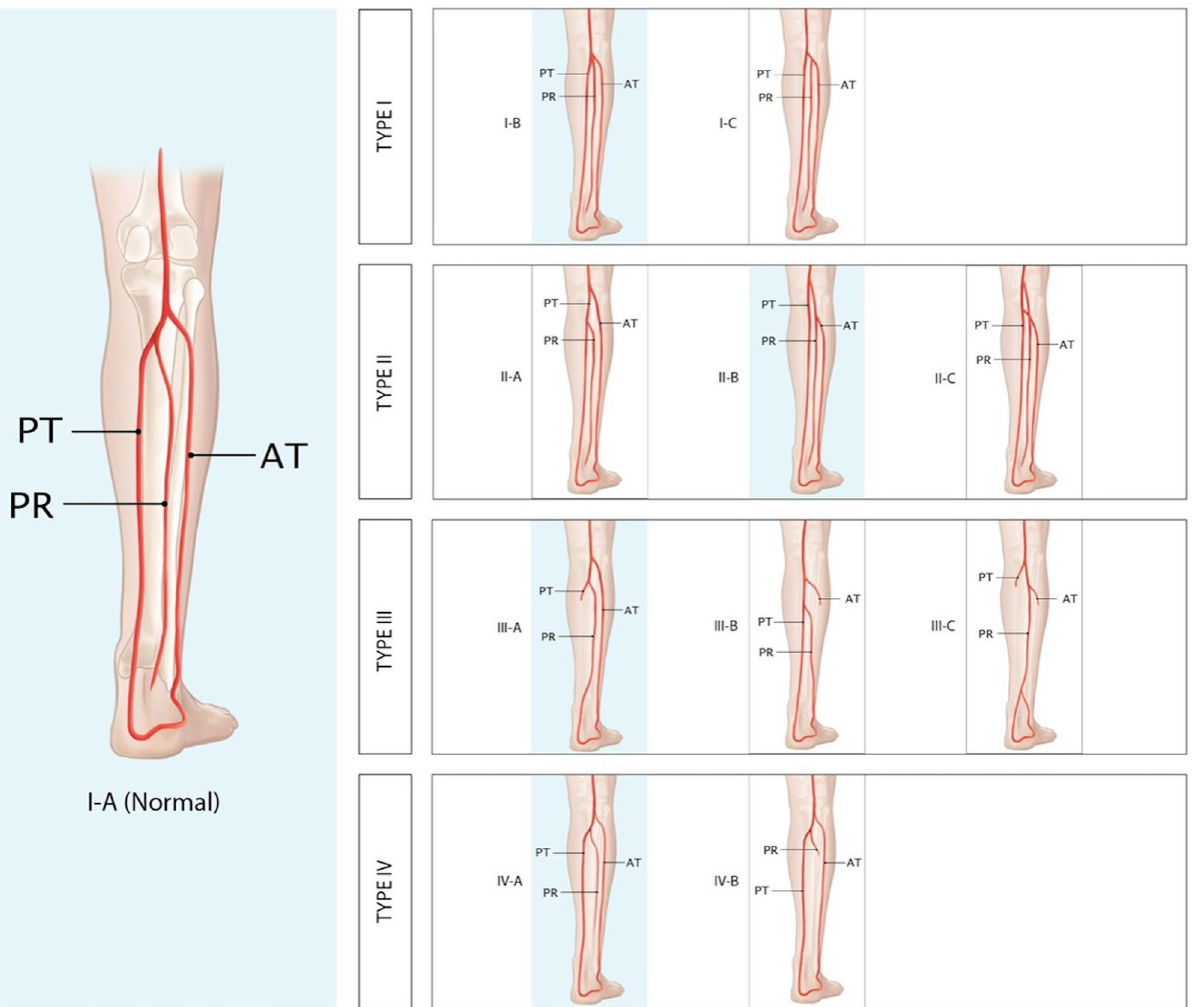
Figure 1. An illustration of popliteal artery (PA) and its branches following classification by Kim et al. and Abou-Foul et al. The popliteal artery branching patterns are classified into 4 major types (I–IV) and divided into 12 subtypes. To note, Type I-A, I-B, II-B, III-A, and IV-A are found in this study (indicated by highlighted in blue rectangles). Type I-A: The common pattern of the popliteal artery and its branches. Type I-B: Trifurcation, AT, PT, and PR arise from the same point, Type I-C: The PT is the first branch, then AT and PR arise from common trunk. Type II-A: The AT arises above the knee joint. Type II-B the PT arises above the knee joint. Type II-C the PR arises above the knee joint. Type III-A: Hypoplastic or aplastic of PT and distal PT replaced by PR. Type III-B hypoplastic or aplastic of AT and dorsalis pedis artery is replaced by PR. Type III-C: hypoplastic or aplastic of both AT and PT results in dominant PR, also called “Peronea arteria magna (PAM)”, which distal PT and dorsalis pedis artery are replaced by PR. Type IV-A: Hypoplastic of PR. Type IV-B: Aplastic of PR. Type III-A and III-B have surgical significance due to the fact that the distal limb will be only supplied by remaining AT or PT, respectively, after FFF harvesting. Type III-C, the dominance of PR without AT and PT supply distal limb, which is contraindicated for FFF harvesting due to the unusable flap. PA popliteal artery, AT anterior tibial artery, PT posterior tibial artery, and PR peroneal might occur from abnormal formation of the arterial system during embryogenesis which results in higher prevalence of III-A than III-B in most studies (Table 3). Other variants found in this study are type I-B, II-B, and IV-A with the percentage of 1.2%, 1.2%, and 0.6%, respectively. Other patterns, which were not mentioned above, were not found in this study. It was found that only 70 out of 81 cadavers have symmetrical common PA branching patterns compared to both legs due to the high number of this typical symmetrical pattern. FFF harvesting can be performed on at least one leg in most cases. However, the other 7, out of 81 cadavers, have asymmetrical patterns, common pattern in one leg and a variant in the other (Table 2). Therefore, if we found the variant pattern in one leg intraoperatively, the likelihood of the common pattern in the contralateral leg was 63.6%. Typically, the distal AT and PT pulse are palpable at just above the foot’s dorsum and medial malleolus, respectively 10 . Type III-A variant, hypoplasia or aplasia of the PT, leading to the replacement of distal PT by the